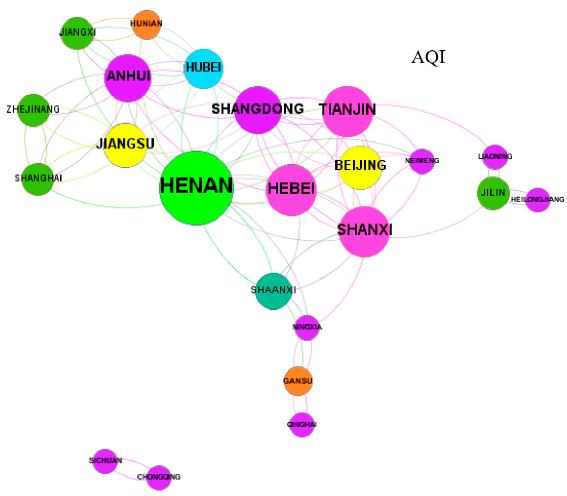
Figure 4. AQI spatial correlation network in 2019.